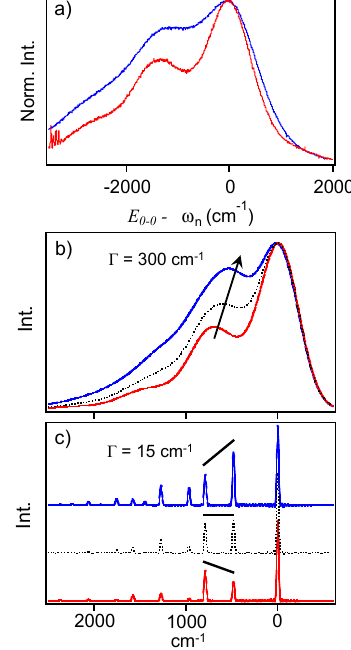
Figure 4. ( a ) Sub-ensemble single MEH-PPV chain PL spectra from “red” and “blue” forms (red and blue traces, respectively) for both experimental and simulated PL spectra; ( b ) Calculated PL spectra of MEH-PPV sub-ensemble emitters using the simplified two-mode model with a damping constant of 300 cm − 1 . Arrow indicates shift of the apparent vibronic interval; ( c ) Calculated PL spectra of MEH-PPV emitters using the simplified two-mode model with a damping constant of 15 cm − 1 . Black lines are included as a guide for the eye and illustrate underlying trends of the intensity distributions for the broadened intervals in ( b ).